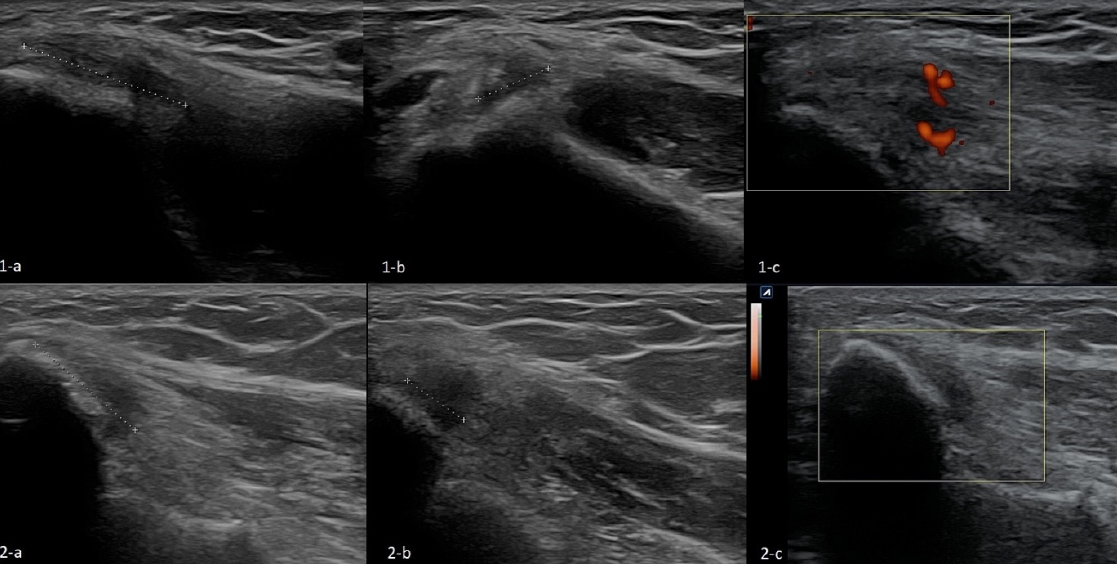
Figure 5. Ultrasound examination of the ulnar nerve. ( a )—Short-axis view at the level sulcus of the nerve; small arrows—ulnar nerve; open arrowheads—Osborn’s ligament; ME—medial epicondyle. ( b )—Short-axis view just distal to the medial epicondyle; small arrow—ulnar nerve; FCU1—hu- meral head of the flexor carpi ulnaris; FCU2—ulnar head of the flexor carpi ulnaris; arrowheads— Osborn’s band connecting proximal parts of both heads of the flexor carpi ulnaris. ( c )—Long-axis view of the ulnar nerve-arrows; ( d , e )—a method of applying the probe to obtain both ( d )—trans- verse and ( e )—longitudinal sections.